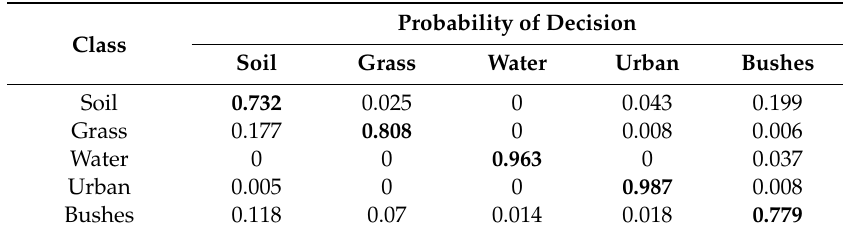
Table 15. Classification probabilities (confusion matrix) for the MLM method trained for the original image and applied to the compressed image (PSNR-HVS-M = 42 dB).